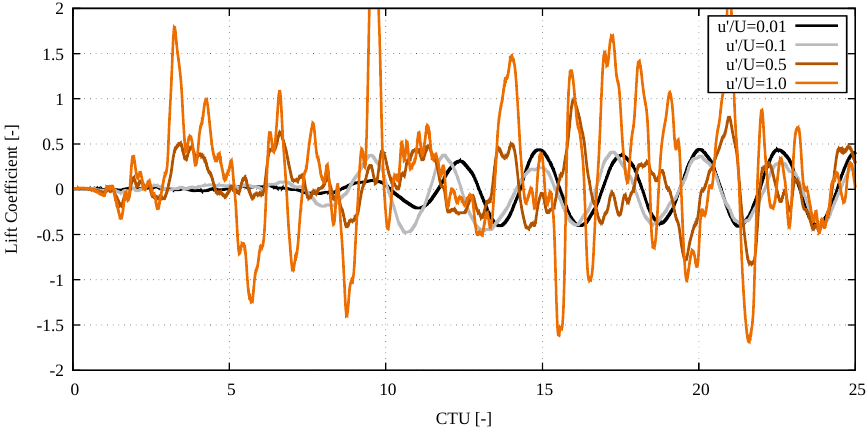
Figure 9. Temporal evolution of the cylinder lift